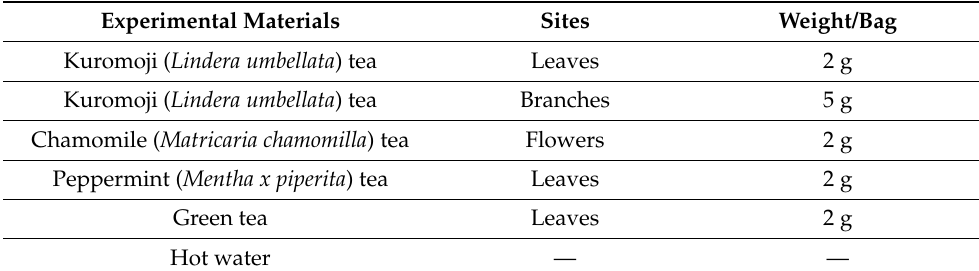
Table 5. Experimental materials. Experimental Materials